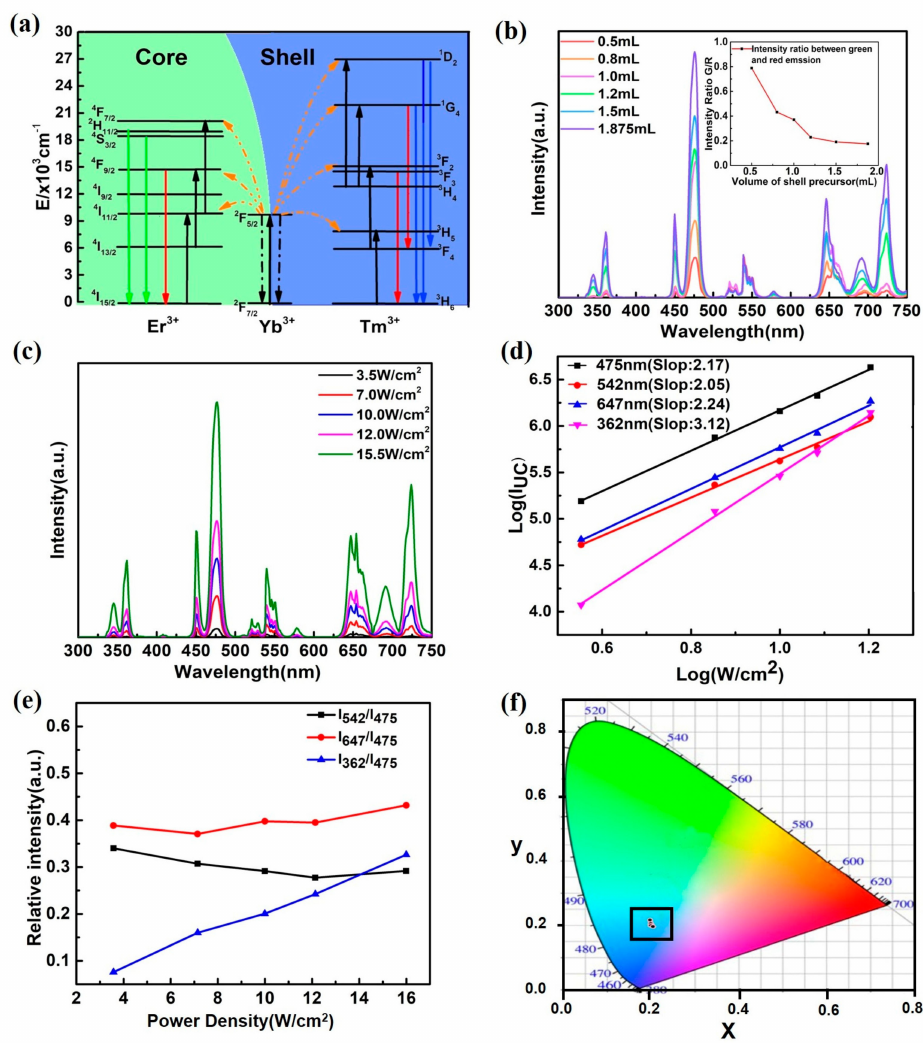
Figure 3. ( a ) Schematic diagram of the energy levels of Er 3+ , Yb 3+ , and Tm 3+ and UC progresses under 980 nm laser excitation; ( b ) UCL spectra of the core-shell microcrystals with different volumes of shell precursor under the irradiation of 980 nm (~10 W/cm 2 ) (red: 0.5 mL; orange: 0.8 mL; yellow: 1.0 mL; green: 1.2 mL; cyan: 1.5 mL and blue: 1.875 mL); The inset of ( b ) shows the G/R ratio as the function of the volume of shell precursor; ( c ) pump-power-dependent UCL emission spectra of core-shell structured microcrystals (with both Er 3+ and Tm 3+ character emissions); ( d ) log–log plots of UC emission intensity versus excitation power density; ( e ) relative intensity of different emission bands under different irradiation (black, red and blue lines represent core-shell microcrystals); ( f ) International Commission on Illumination (CIE) chromaticity coordinates of the emission for different excitation power